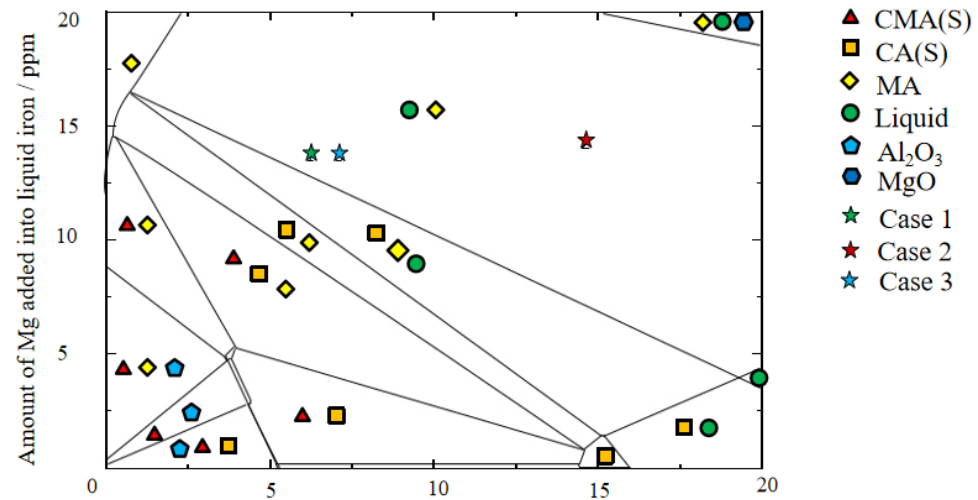
Figure 13. Stable phase diagram of inclusions in Fe–Al–Ca–Mg–O system.